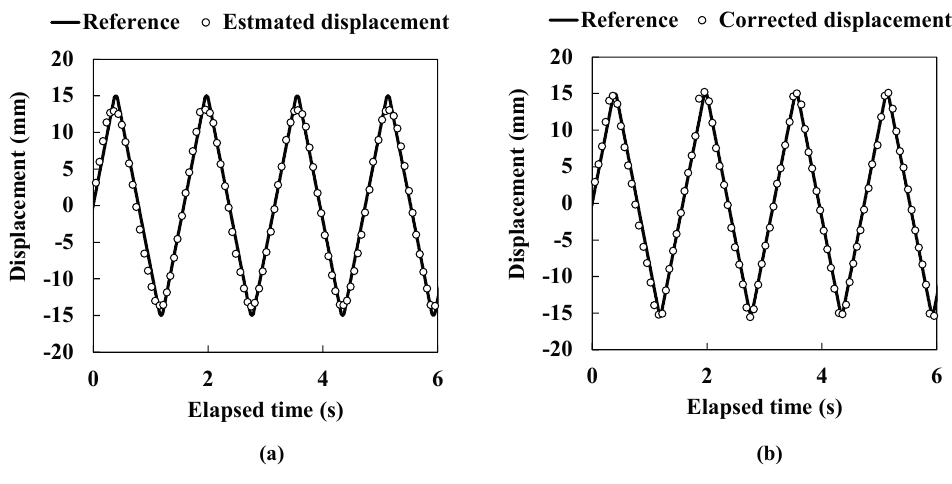
Figure 10. The dynamic response experiment in 0.6 Hz movement. ( a ) Estimated lateral displacement; ( b ) Corrected lateral